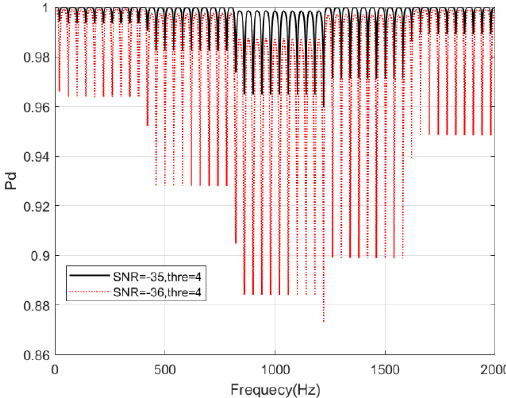
Figure 14. Probability of detection corresponding to a different frequency.